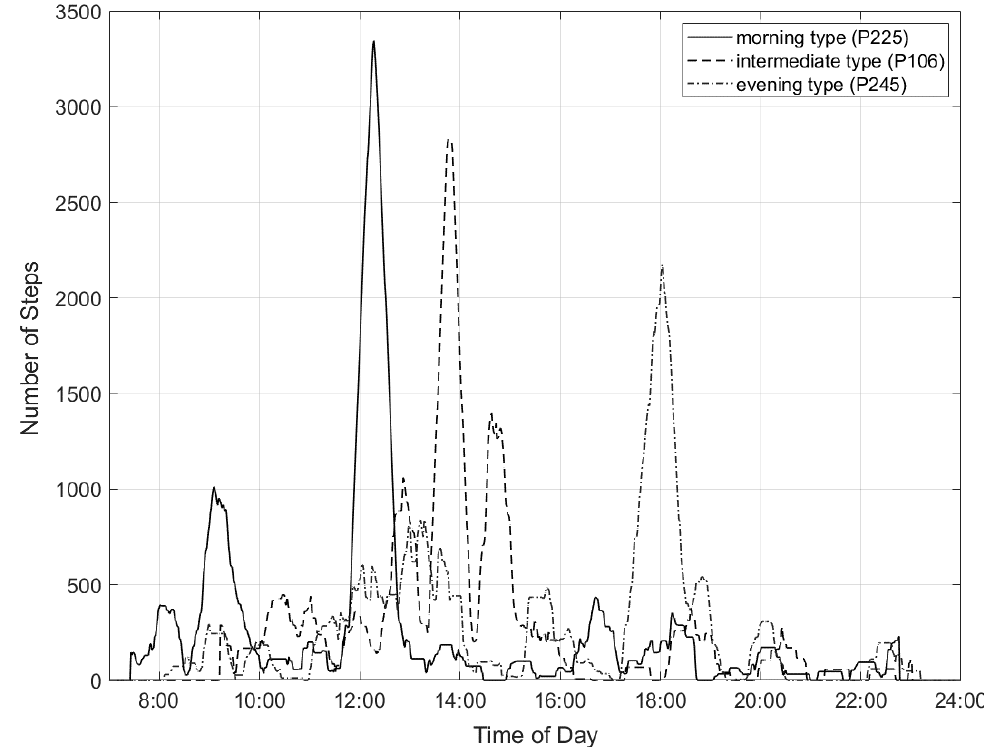
Figure 1. Exemplary analysis of 30-minute active period. Significant differences within the circadian aspects of the step count (MM+) between the three groups were detected (Figures 2 and 3).